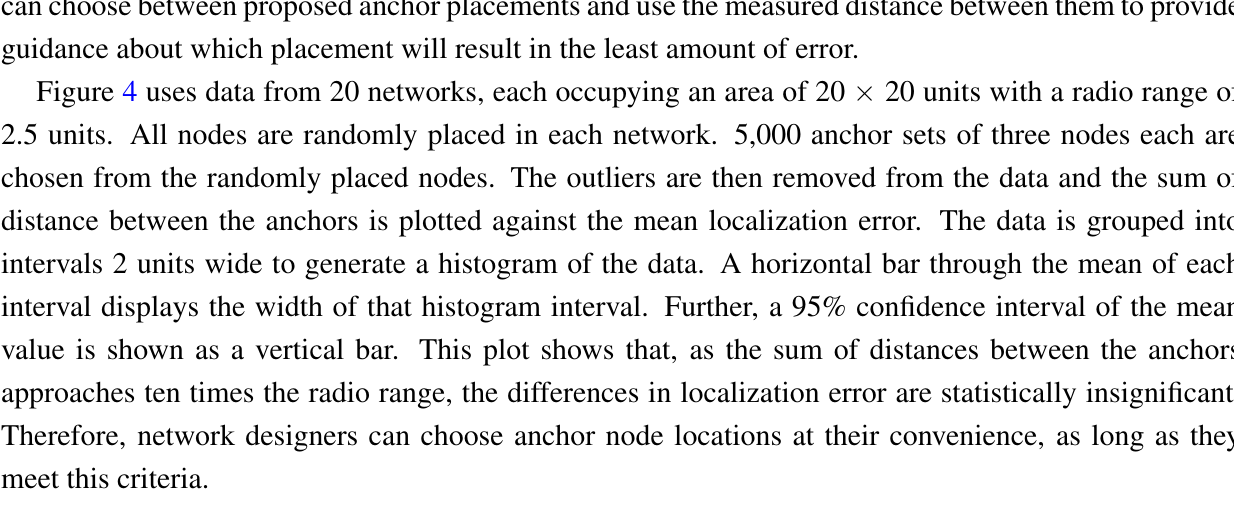
Figure 4. Histogram: Sum of distance between anchors vs . localization error for 20 random square networks, excluding